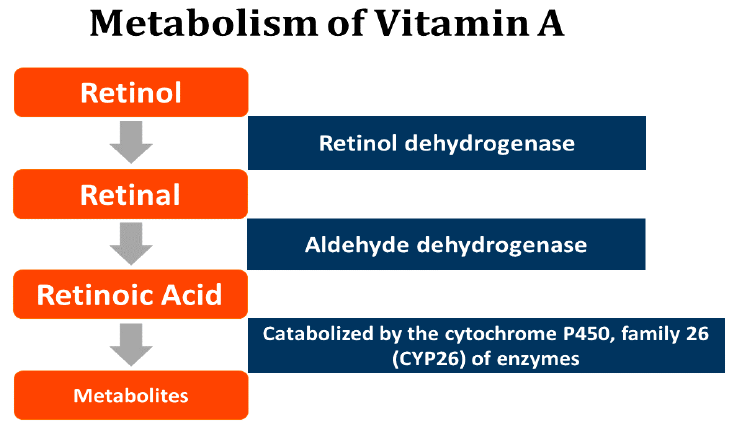
Figure 1. Metabolism of Vitamin A.